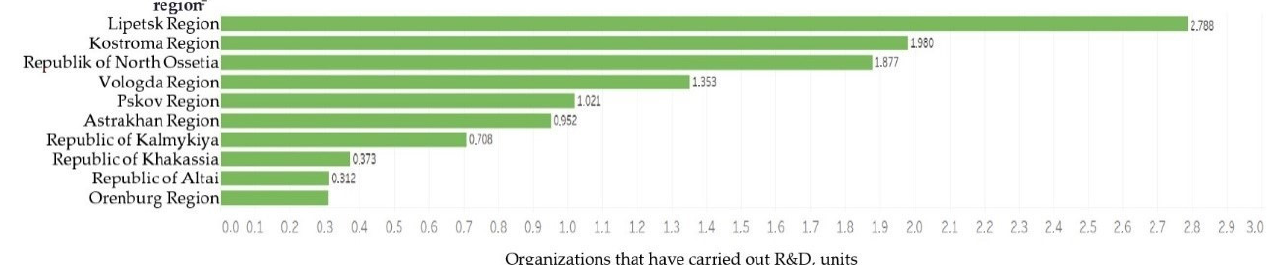
Figure 5. Size of incoming slacks by the indicator of the number of personnel engaged in R&D (res_hum). (res_hum).